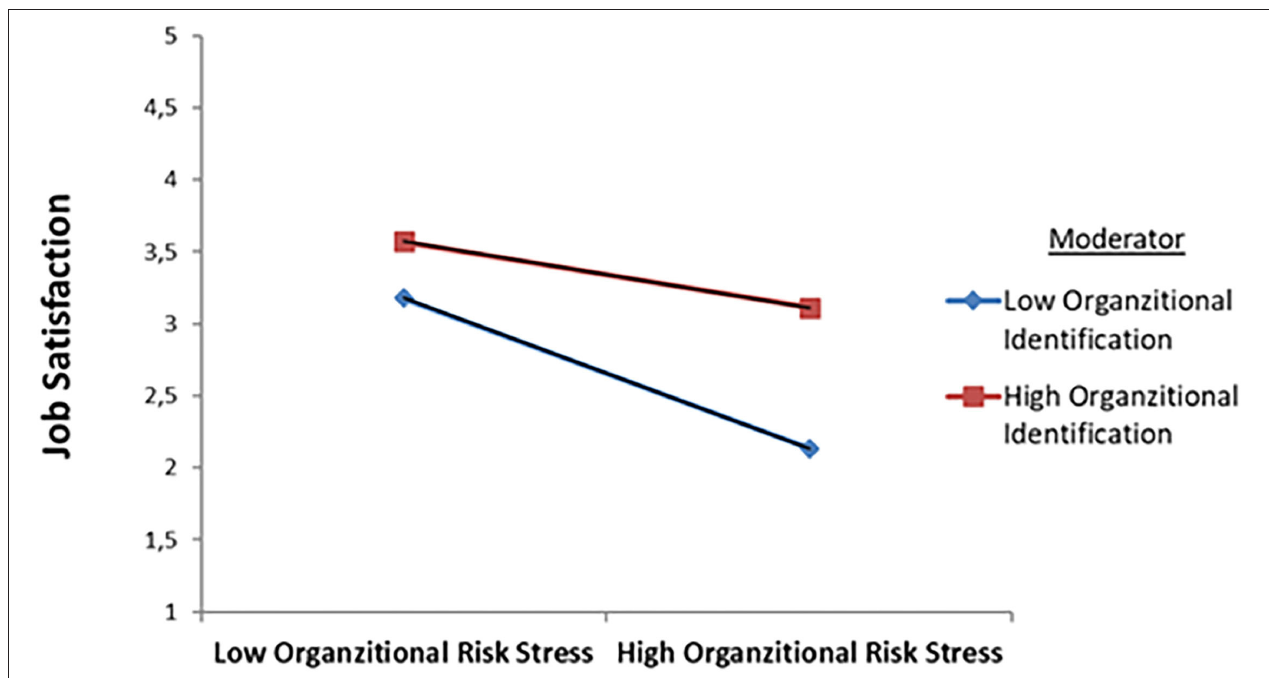
FIGURE 2 | The interaction between OI and